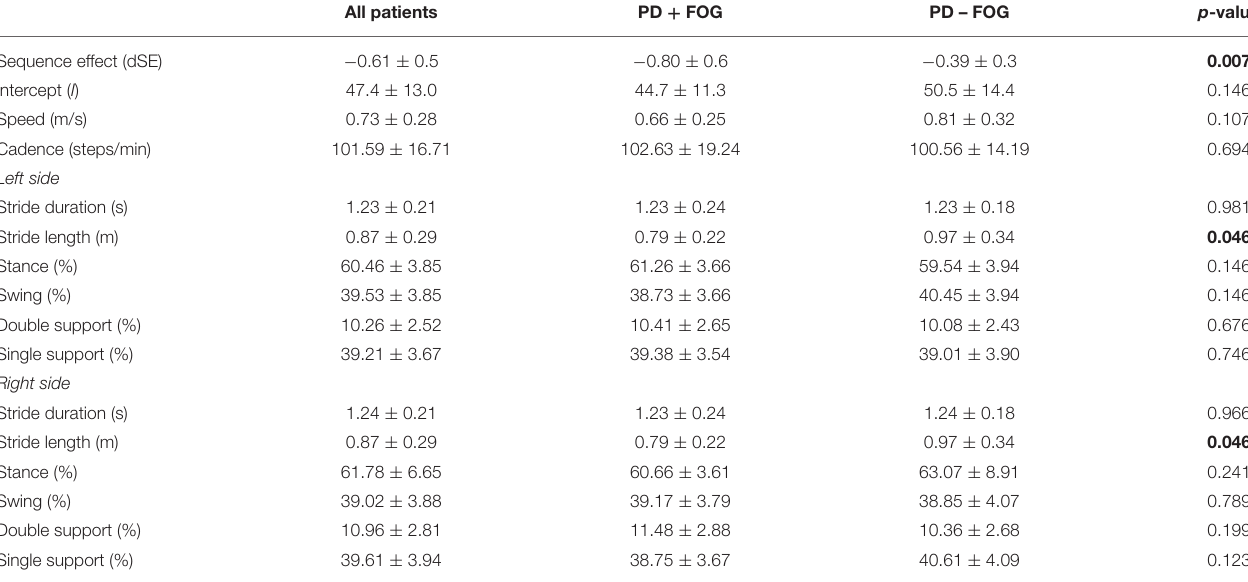
TABLE 2 | Baseline gait features of the study population. All patients PD +